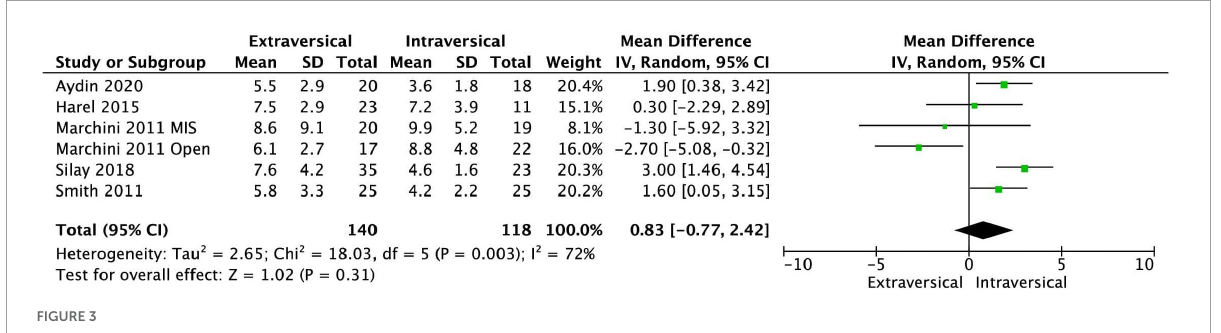
FIGURE3 Forest plot of age at operation in EVUR vs. IVUR